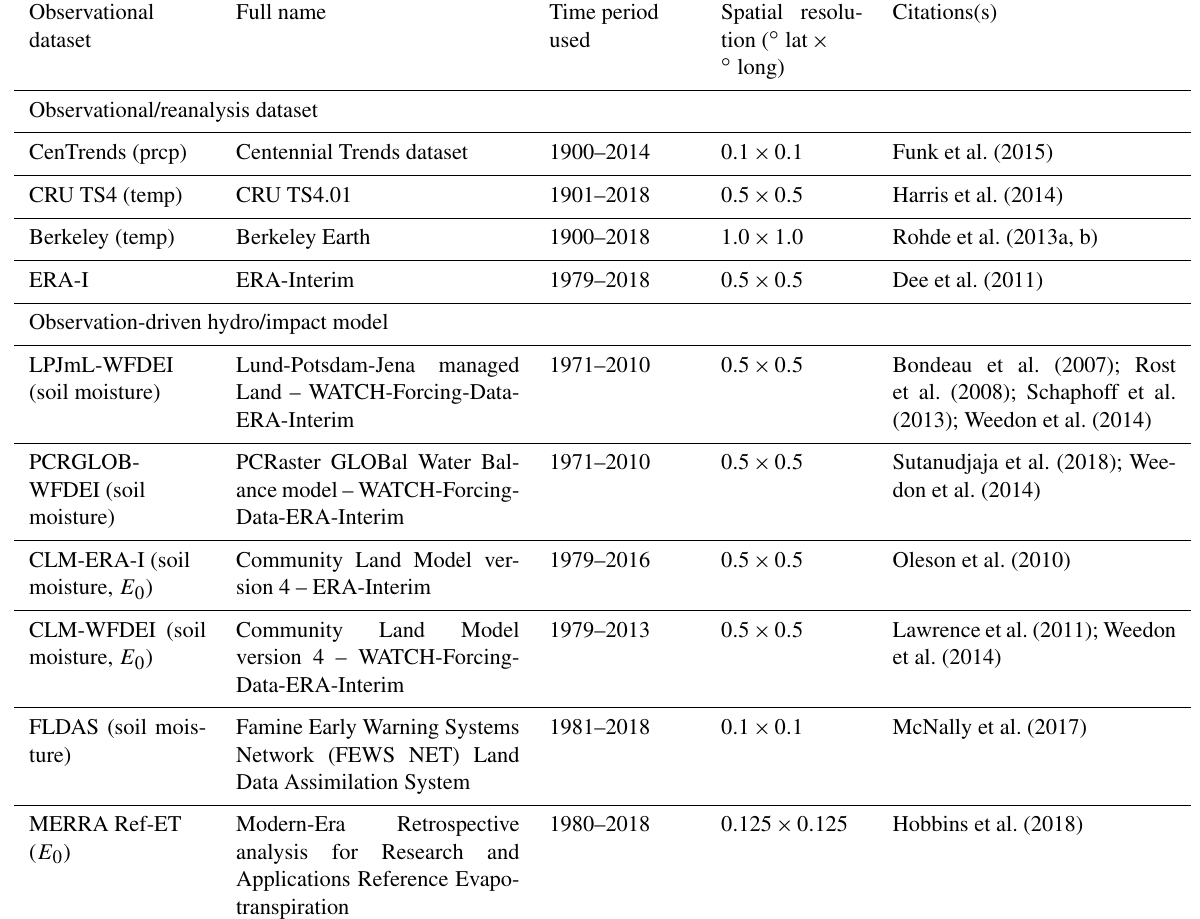
Table 2. Observational data used in this study. Observational dataset Observational/reanalysis